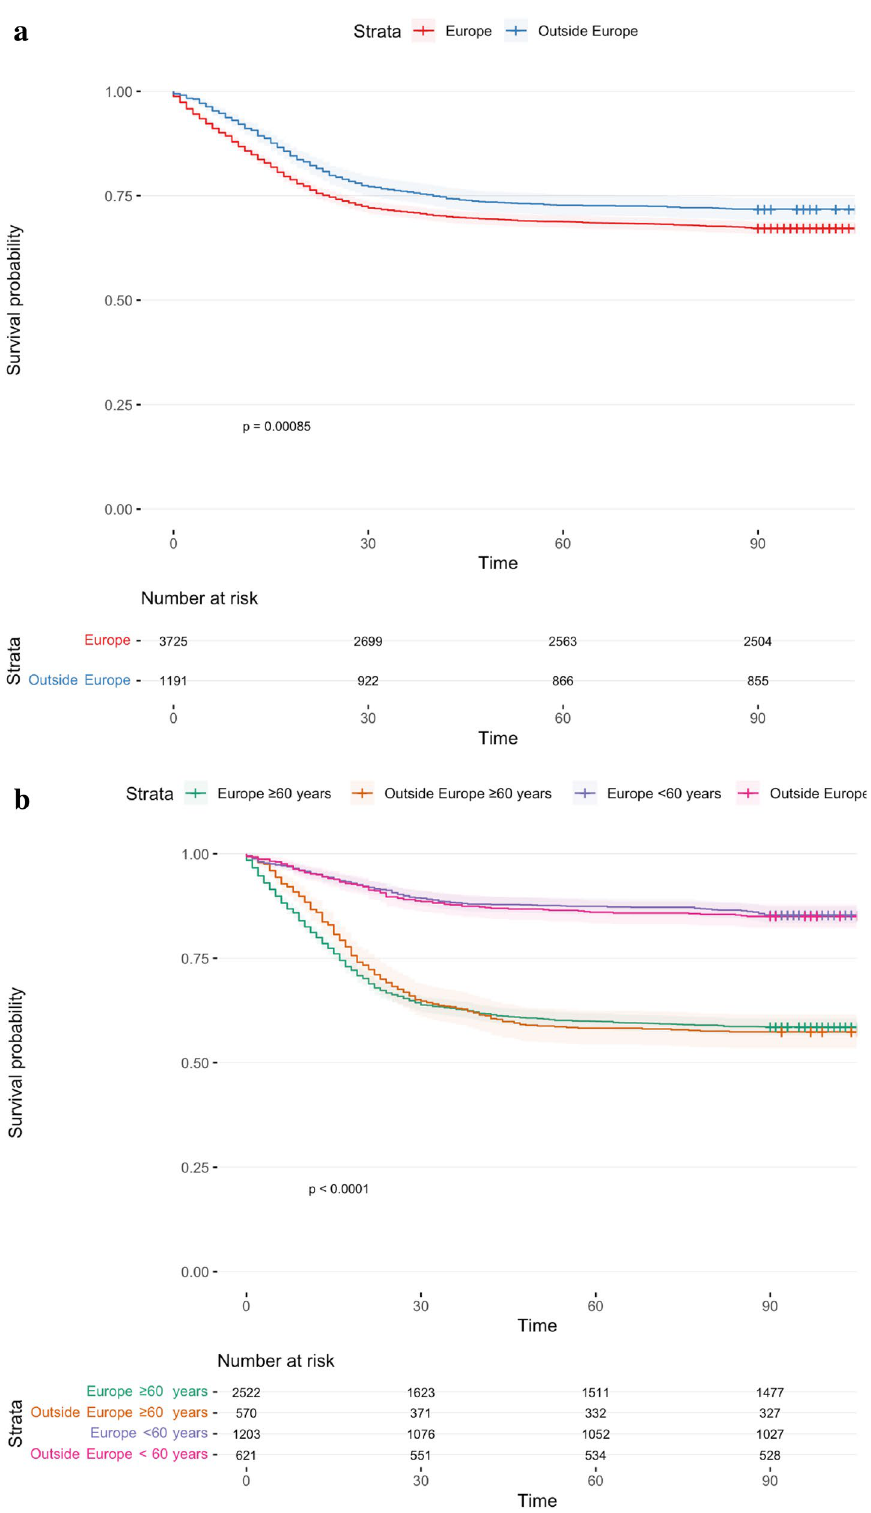
Figure 3. ( a ) Kaplan–Meier survival curves for patients with severe Covid-19 stratified by region of birth (Europe vs. outside Europe). ( b ) Kaplan–Meier survival curves for patients with severe Covid-19 stratified by age (younger than 60 years vs. older than/or equal to 60 years) and region of birth (Europe vs outside